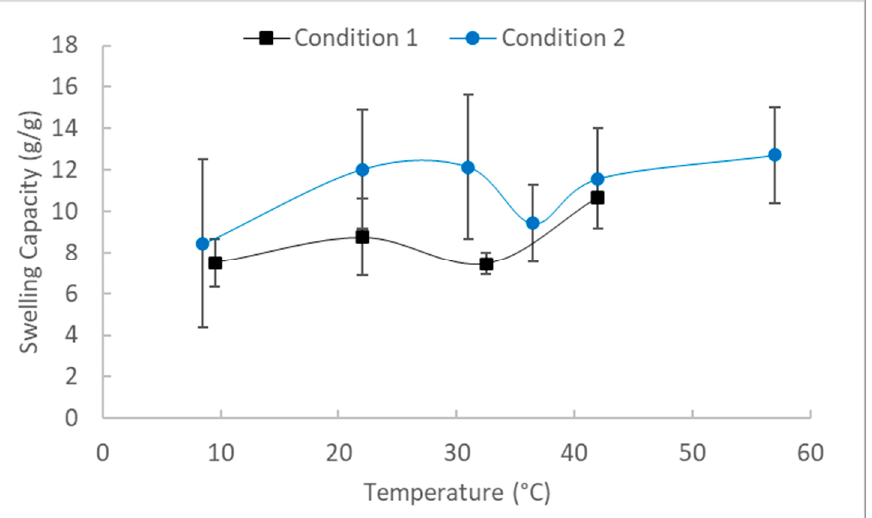
Figure 7. Effects of water temperature in the swelling capacity of CS-MB. Condition 1: 6.0 ± 2.0 mg CS-MB immersion in 5 mL unbuffered distilled water for 0.5 h. Condition 2: 4.5 ± 1.5 mg CS-MB, immersion in 5 mL pH 4 buffered solution for 11 h. The error bars represent standard deviation.